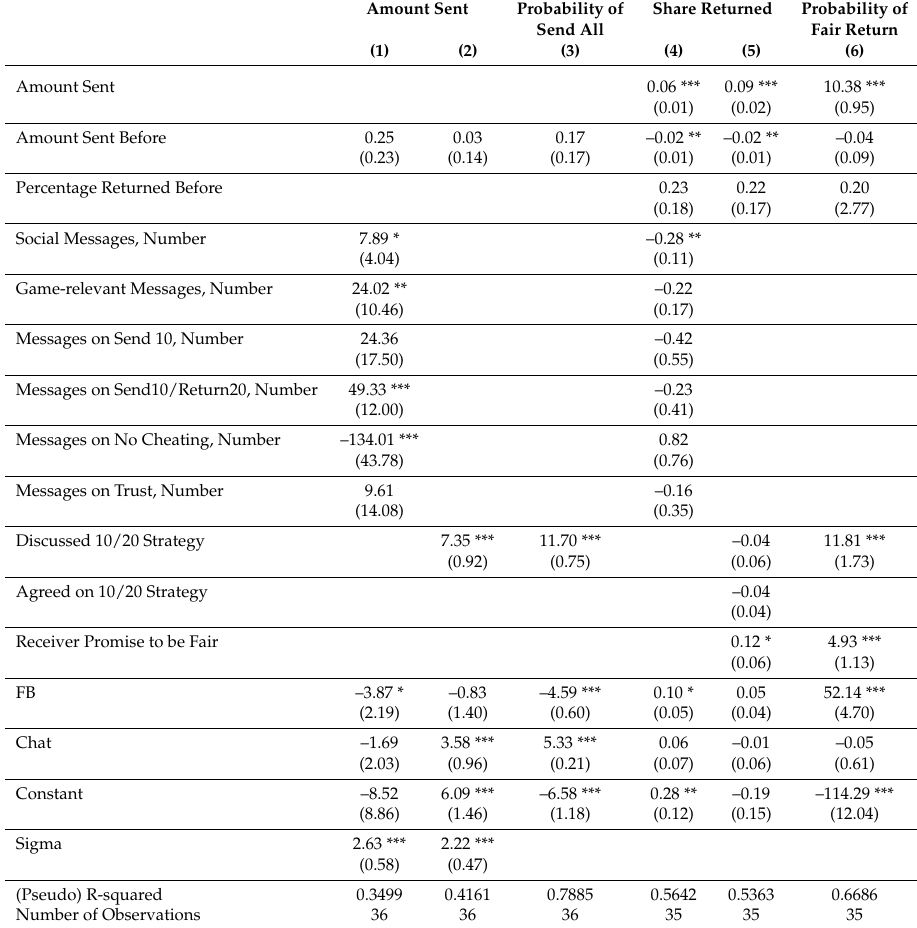
Table 9. Effect of communication volume and